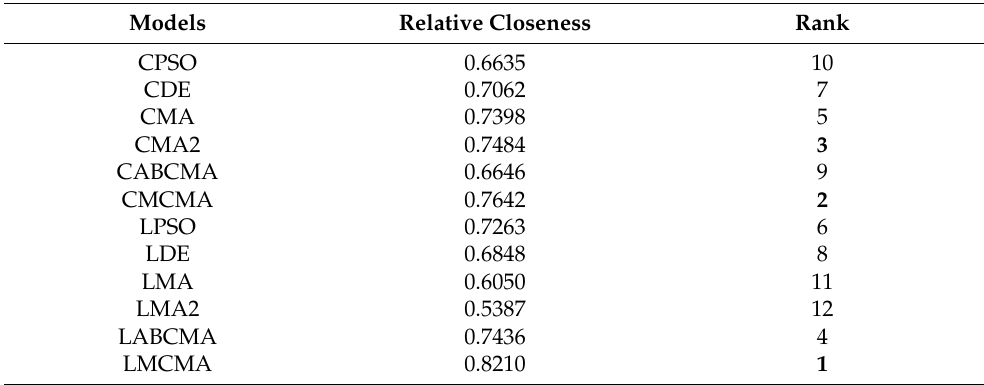
Table 6. Ranking for BTC/USD dataset.